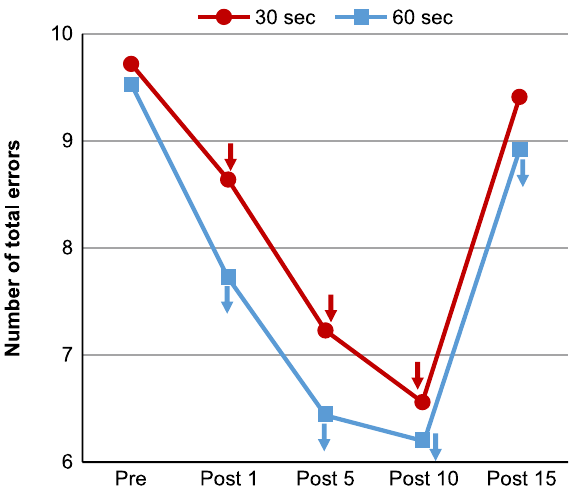
Figure 1. Number of total errors on BESS for both protocols for the five assessments. Statistically signifi- cant differences at the .05 level on post-test measure- ments with respect to the pre-test values for each proto- col are denoted by an arrow.